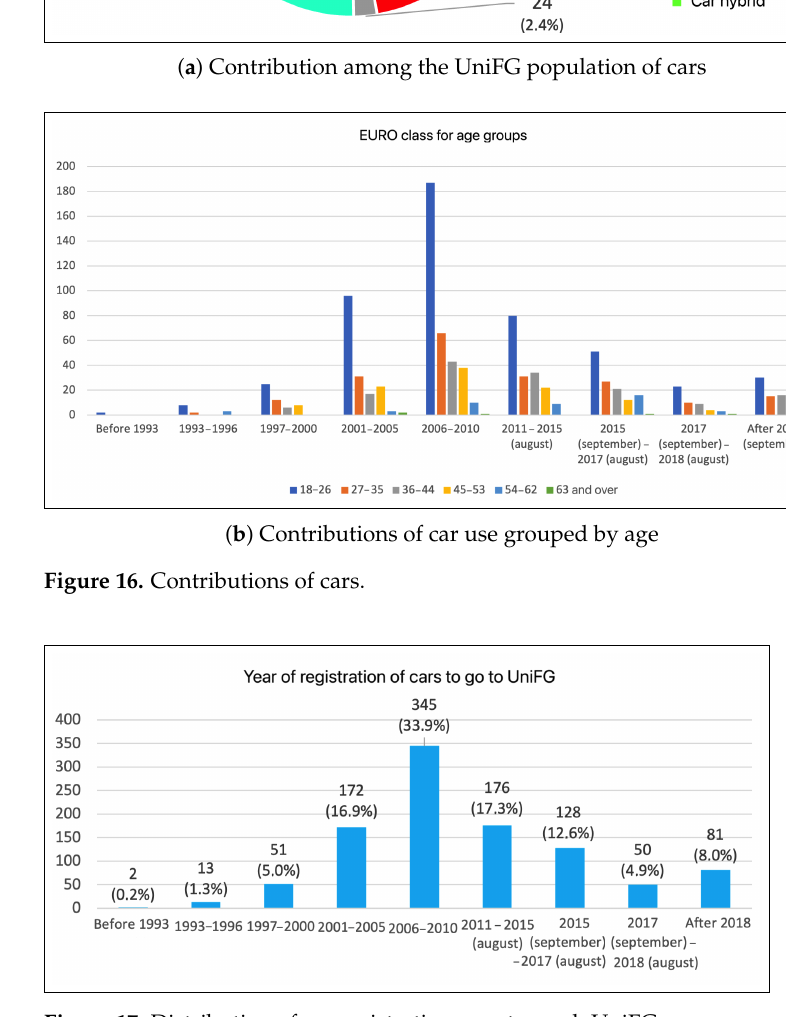
Figure 17. Distribution of car registration year to reach